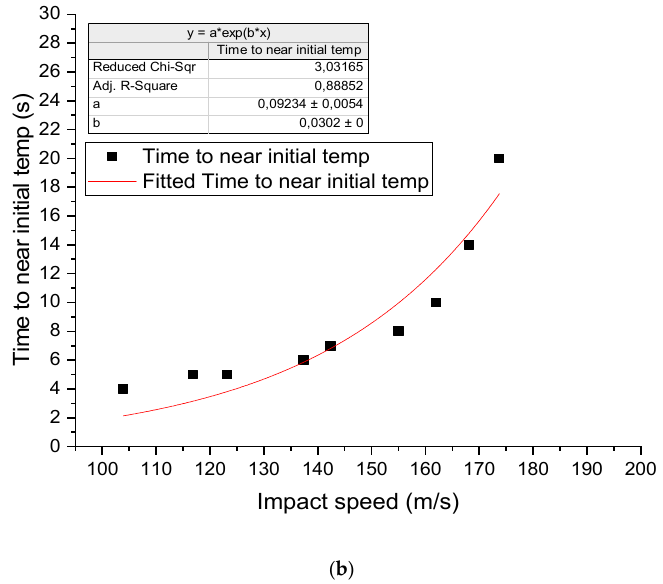
Figure 4. ( a ) Time-temperature variation of the PU coating, the temperature is the average temperature within the impact area shown in blue, and on the second y axis, the corresponding impact speed shown in red dots can be seen. ( b ) The measured time to thermal equilibrium as a function of the impact speed data fitted with an exponential curve to construct an empirical function for cool-down time as a function of impact speed. Based on these data, a control curve was constructed by fitting a power function to the cool-down times as seen in Figure 4b.